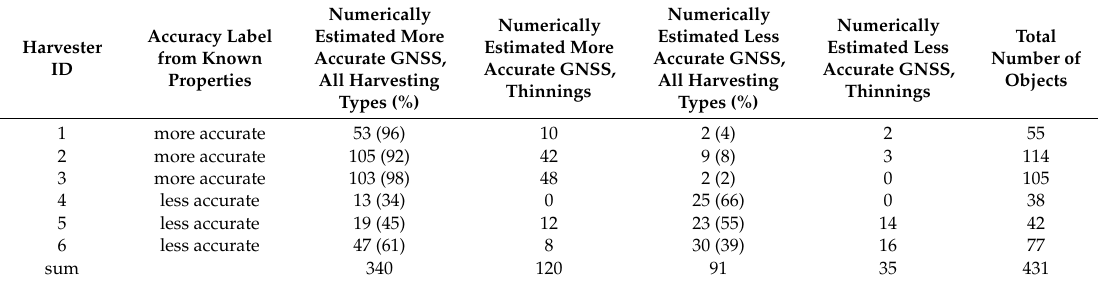
Table 3. The correspondence of numerically estimated GNSS accuracy with GNSS accuracy obtained from known properties of harvesters. The numbers indicate how many objects belong into each category. Thinnings include in this table both first and later thinnings. The hold-over cutting objects have been excluded. Additionally, two objects were left out as all the points had same one GNSS location and the numerical estimate could therefore not be